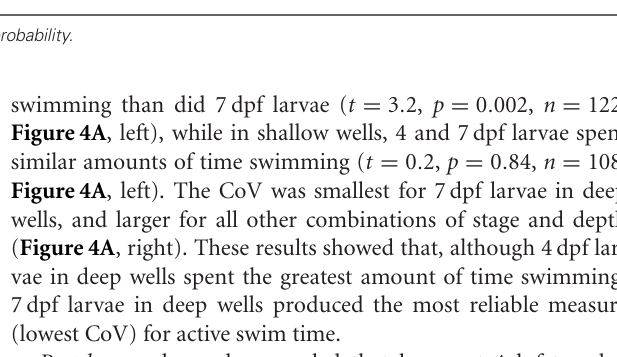
p = 0 . 02) and total distance ( F = 6 . 31, p = 0 . 01). Post-hoc